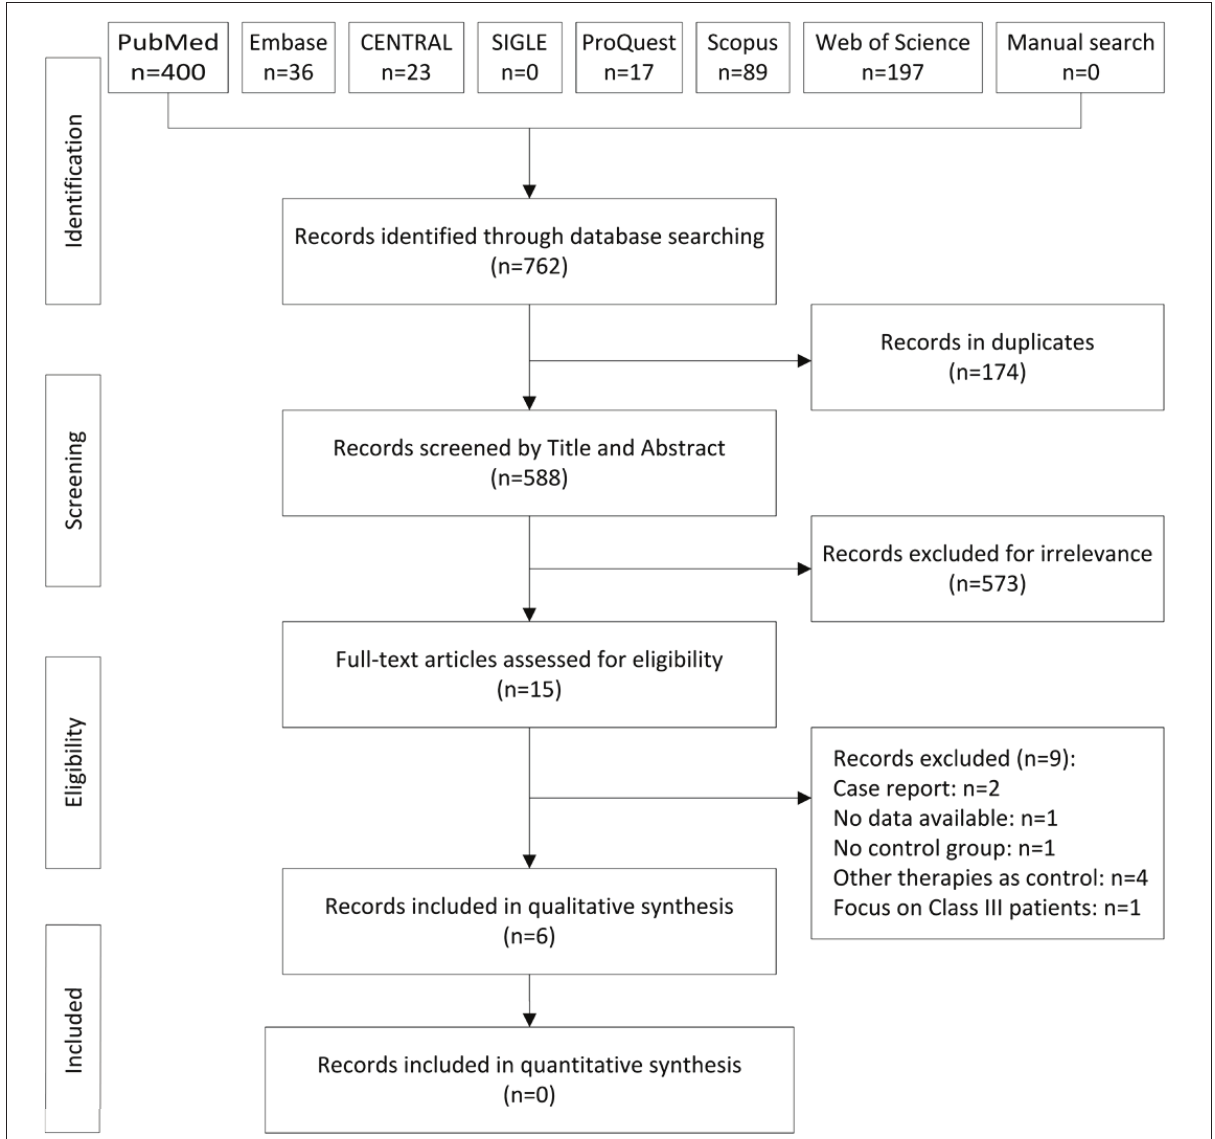
Figure 1. PRISMA flow diagram of study inclusion.